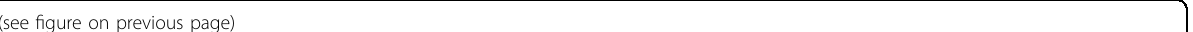
Fig. 1 Caspase-9/GSDME trigged pyroptosis of syncytia formed by fusion of SARS-CoV-2 Spike and ACE2-expressing cells. SARS-CoV-2-S- GFP HeLa cells were co-cultured with PLC-RFP-A549-ACE2 cells ( a ), or NLS-RFP-A549-ACE2 cells ( b ) at a 1:1 ratio. Four hours later, image was scanned by LSM780. The nucleus (blue) was stained by Hoechst; Bar, 20 μ m. c The time-phase of cell-cell fusion progress, HeLa-ACE2 co-culture with HeLa- SARS-CoV-2-S cells, treatment with pan-caspase inhibitor, ZVAD (20 μ M) or not; Images were obtained at 3 h, 6 h, 12 h 24 h; the nucleus(blue) was stained by Hoechst; Bar, 100 μ m; then the cell-cell fusion was quanti fi ed ( d ); the LDH release ( e ), ATP level ( f ), the activity of caspase-3/7 ( g ) were detected at indicated time. Western blot analysis of the cells collected as indicated. ACE2, Flag, caspase-8 (C8), caspase-9 (C9), caspase-7 (C7), Cleaved-caspase-3 (Cleaved-C3), and GSMDE were probed. β -Actin as loading control ( h , k and n ). The cell-cell fusion was quanti fi ed after co-culture for 5 h as indicated ( i and l ). LDH release was measured after co-culture for 12 h as indicated ( j and m ). The model of SARS-CoV-2 Spike and ACE2 interaction induced syncytia pyroptosis ( o ). The data were shown as means ± SD, * P < 0.05, ** P < 0.01, NS non-signi fi cance, and all the experiments were replicated more than three